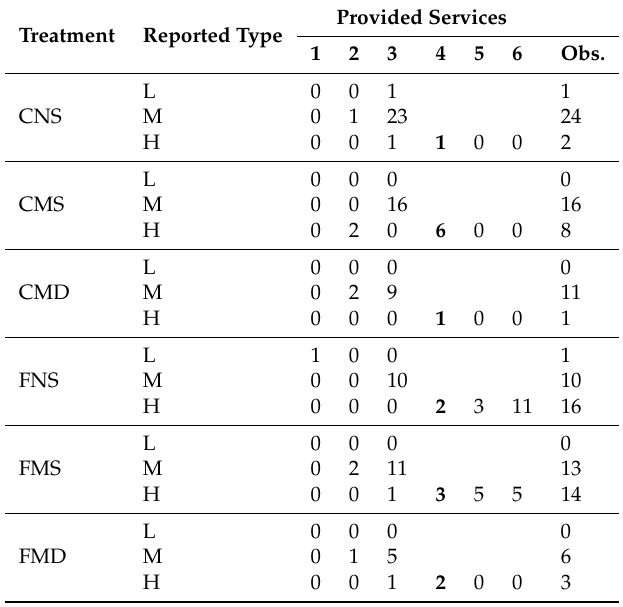
Table A13. Reporting and provision of medical services for Type M Patients . Treatment Reported Type